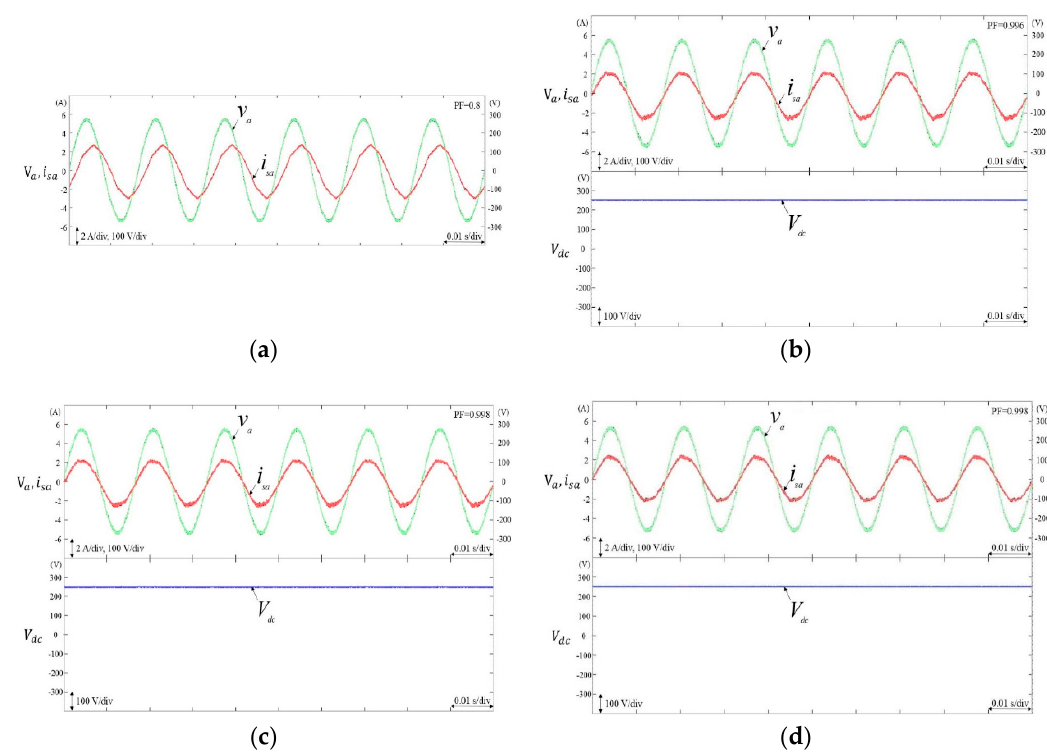
Figure 6. Experimental results at linear inductive load 3: ( a ) Without using DSTATCOM; ( b ) Using PI controlled DSTATCOM; ( c ) Using CFNN controlled DSTATCOM; ( d ) Using proposed CFNN-AMF controlled DSTATCOM.